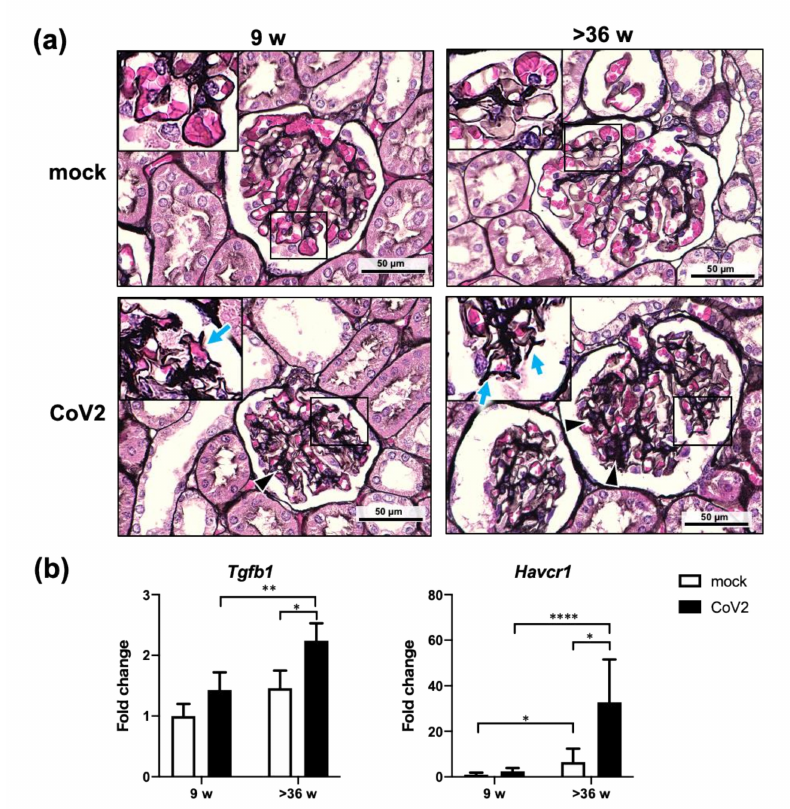
Figure 5. Pathological changes in the kidneys from young and aged hamsters infected with CoV2. Young (9 w) and aged (>36 w) hamsters were intranasally inoculated with PBS control (mock) or PBS containing SARS-CoV-2 virus (CoV2), and hamsters were euthanized at 6 days post infection for the collection of kidney samples for histopathological analyses ( a ) and gene expression analyses ( b ). ( a ) For histopathological analyses, kidney sections were stained with periodic acid–methenamine silver (PAM). Arrowheads indicate increased mesangial substrate. Arrows in the insert panels indicate wrinkle changes in the glomerular basement membranes. ( b ) Gene expression levels of transforming growth factor beta 1 ( Tgfb1 ) and hepatitis A virus cellular receptor 1 ( Havcr1 ) are presented as the fold changes relative to those of young mock hamsters. Bars represent the mean ± SEM [mock (9 w), n = 6; CoV2 (9 w), n = 10; mock (>36 w), n = 6; CoV2 (>36 w), n = 13]. White and black bars indicate data from mock and CoV2-infected hamsters, respectively. * p < 0.05, ** p < 0.01, **** p < 0.0001, two-way ANOVA on dCt values with Sidak’s multiple comparison